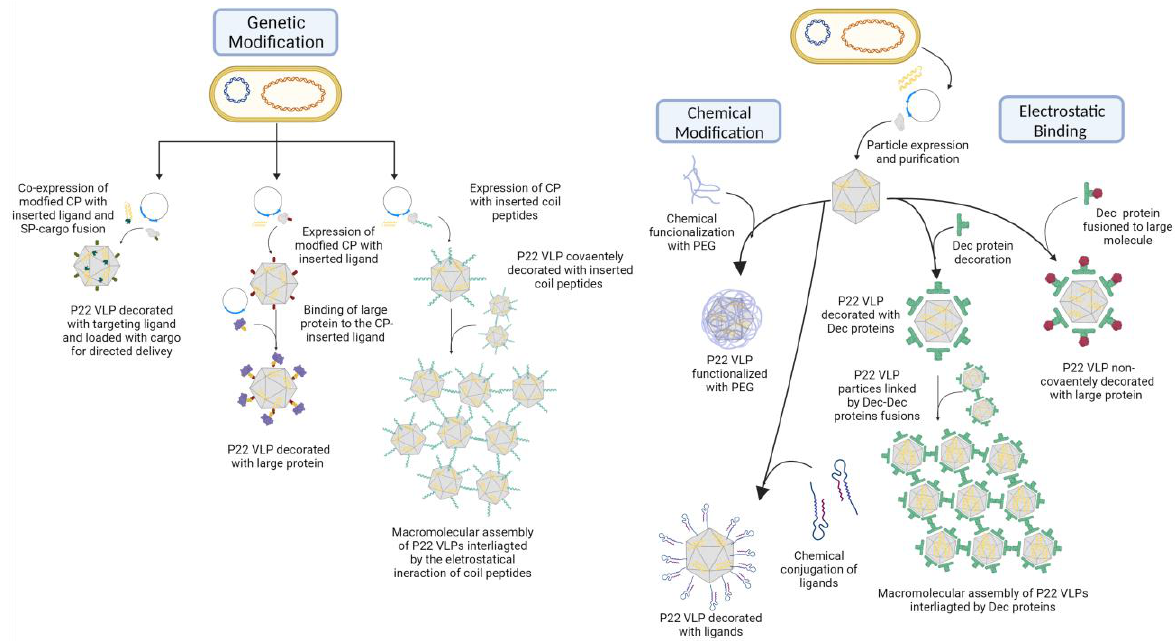
Figure 6. Scheme of different methods for modifying the P22 VLP exterior and particle decoration. On the left, some of the types of structures that were used to genetically decorate the P22 VLP are illustrated, this method consisting of the insertion of a non-native peptide into CPs’ primary sequence. Inserted structures include targeting ligands for the targeted delivery of internalized cargo [9,12,56]; ligand sequences for the annexation of large molecules for molecular presentation or to confer target specificity [12,17,100]; and coil peptides for the development of macromolecular assemblies with P22 VLP [81,87,97]. On the right, the methods for the postexpression modification of VLP particles’ exterior, examples of which include the chemical modification of the particle [9,69,71,85,98] and the electrostatic annexation of foreign structures [60–62,92,102]. Chemical modifications include those with polymers such as polyethylene glycol (PEG) [69,71,98] or the insertion of targeting ligands [9,85]. On the other hand, the use of the electrostatic binding of structures can be explored for the annexation of the Dec protein, allowing the incorporation of large molecules for molecular presentation or to confer target specificity [61,62], as well as the development of macromolecular structures [60,102].